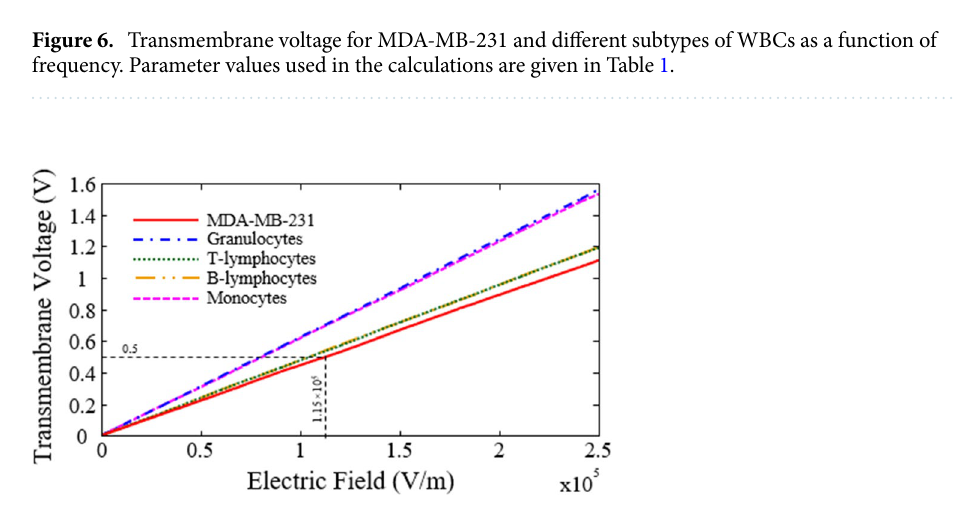
Figure 7. Transmembrane voltage for MDA-MB-231 and different subtypes of WBCs as a function of the electric